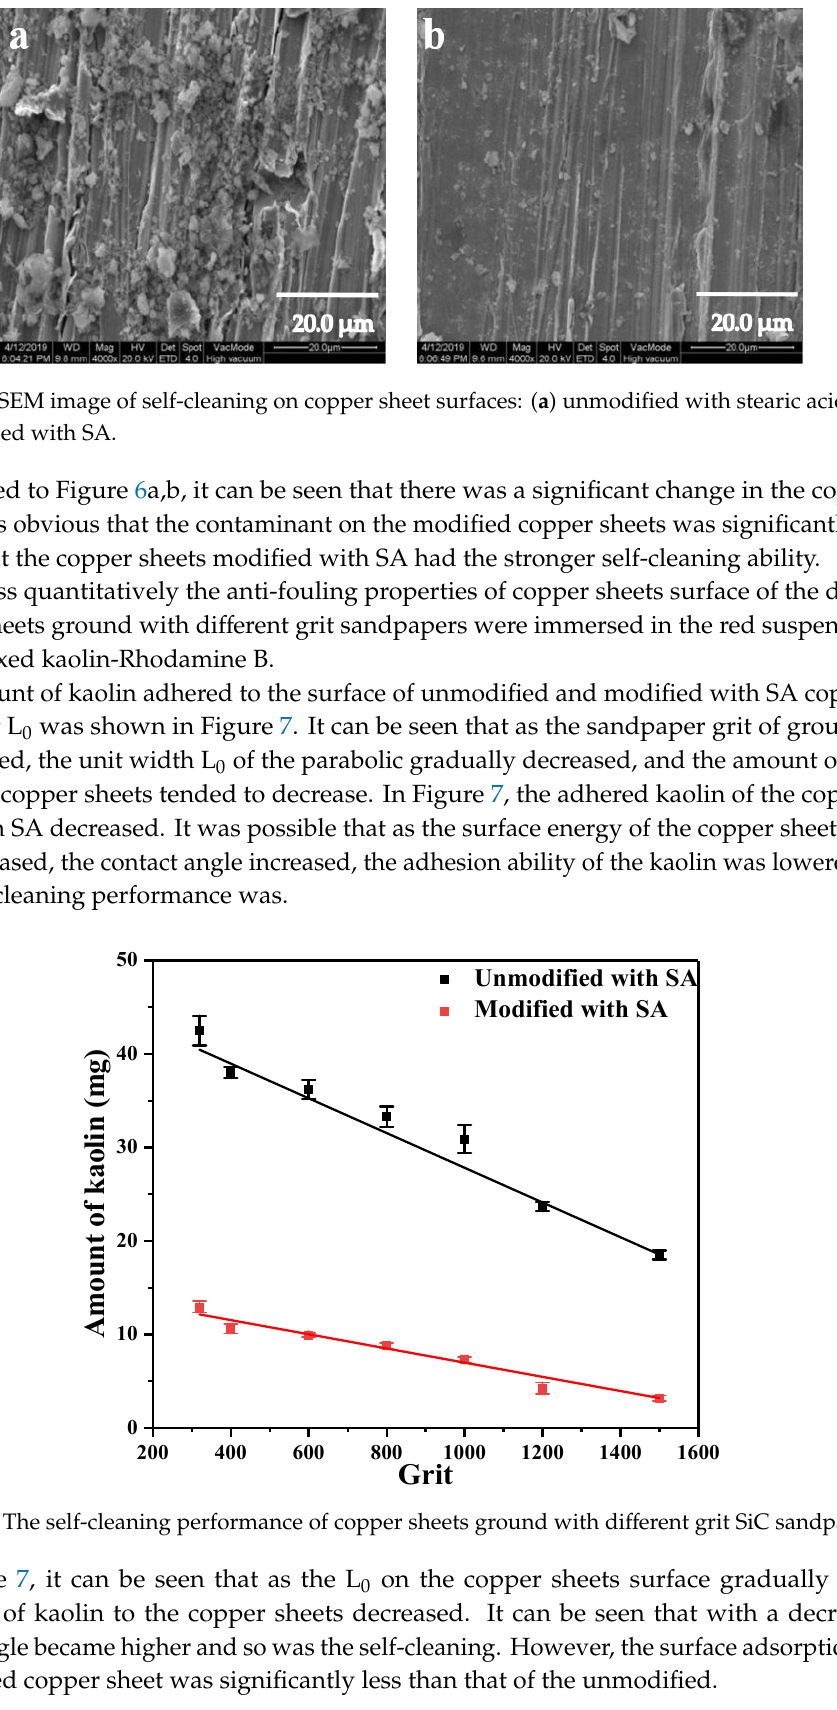
Figure 7. The self-cleaning performance of copper sheets ground with different grit SiC sandpapers.